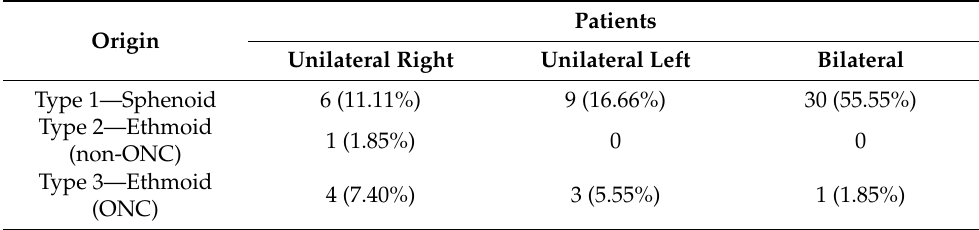
Table 3. Origin and symmetry of the pneumatization from the paranasal sinuses within the optic strut. ONC—Onodi cell. N = 54 cases.